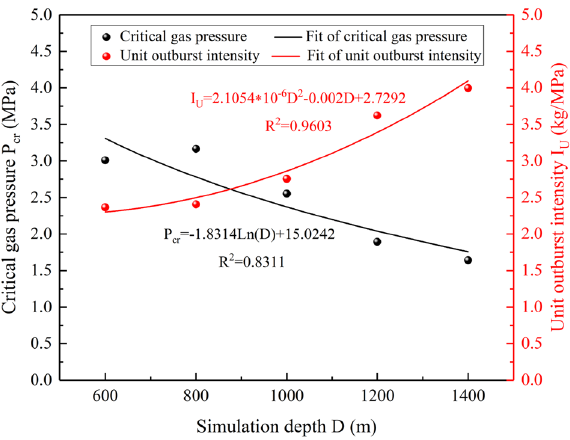
Figure 6. Variation of critical gas pressure and unit outburst intensity with simulation